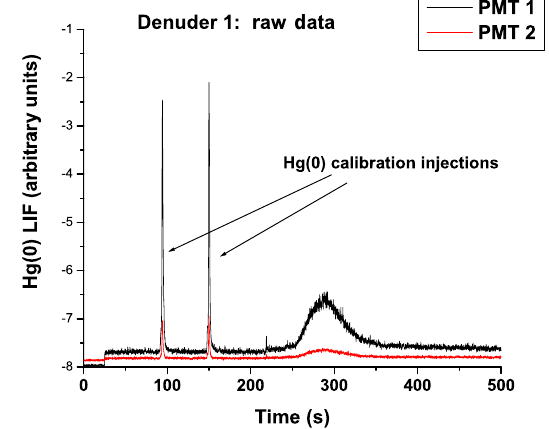
Figure 10. KCl manual denuder measurements from 16 September. The raw data for the TDPs for the denuder D1 are